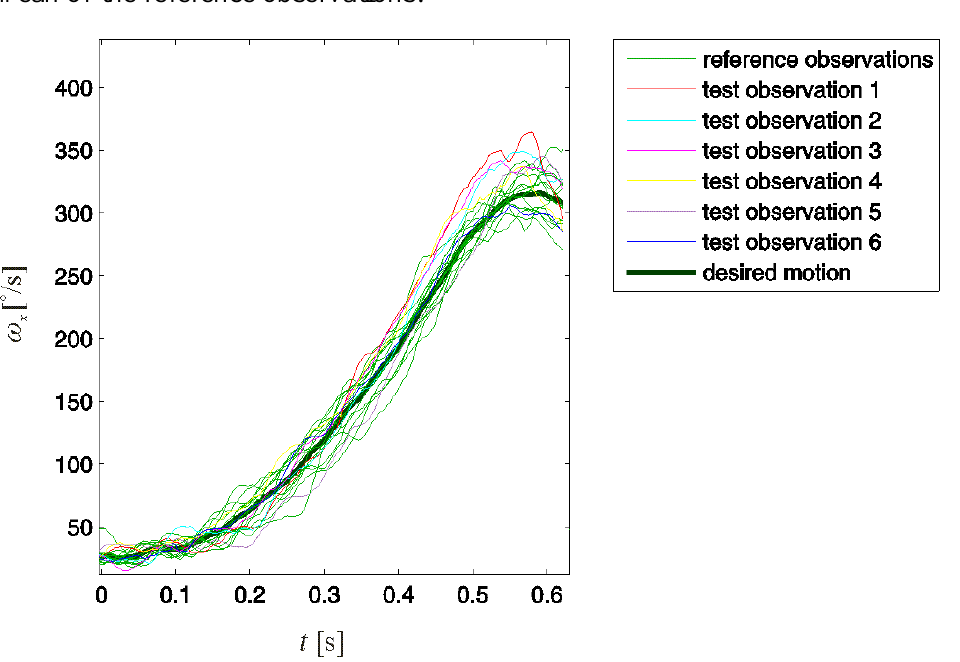
Figure 4. Reference and test observations of the golfer’s leading arm rotation around its intrinsic longitudinal axis during the first 0.625 s of the backswing. All